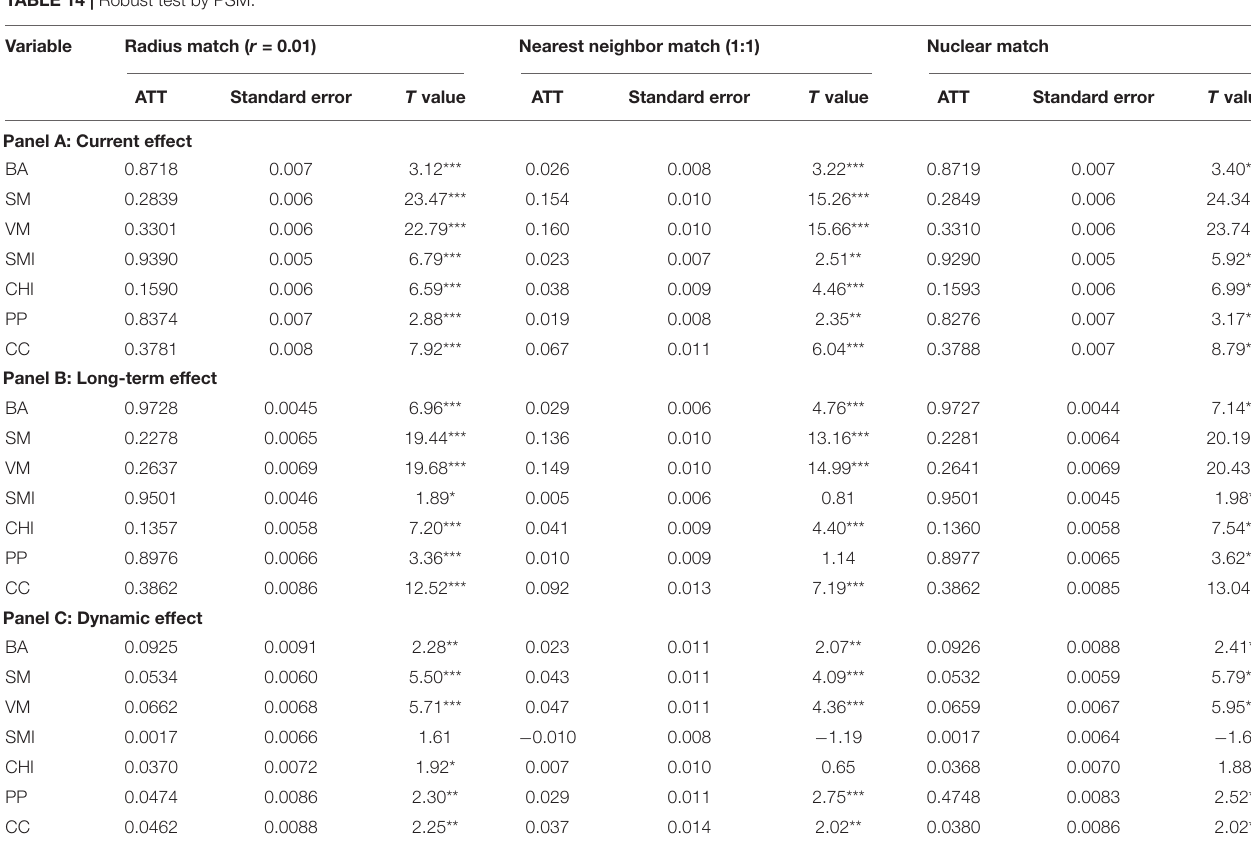
TABLE 14 | Robust test by